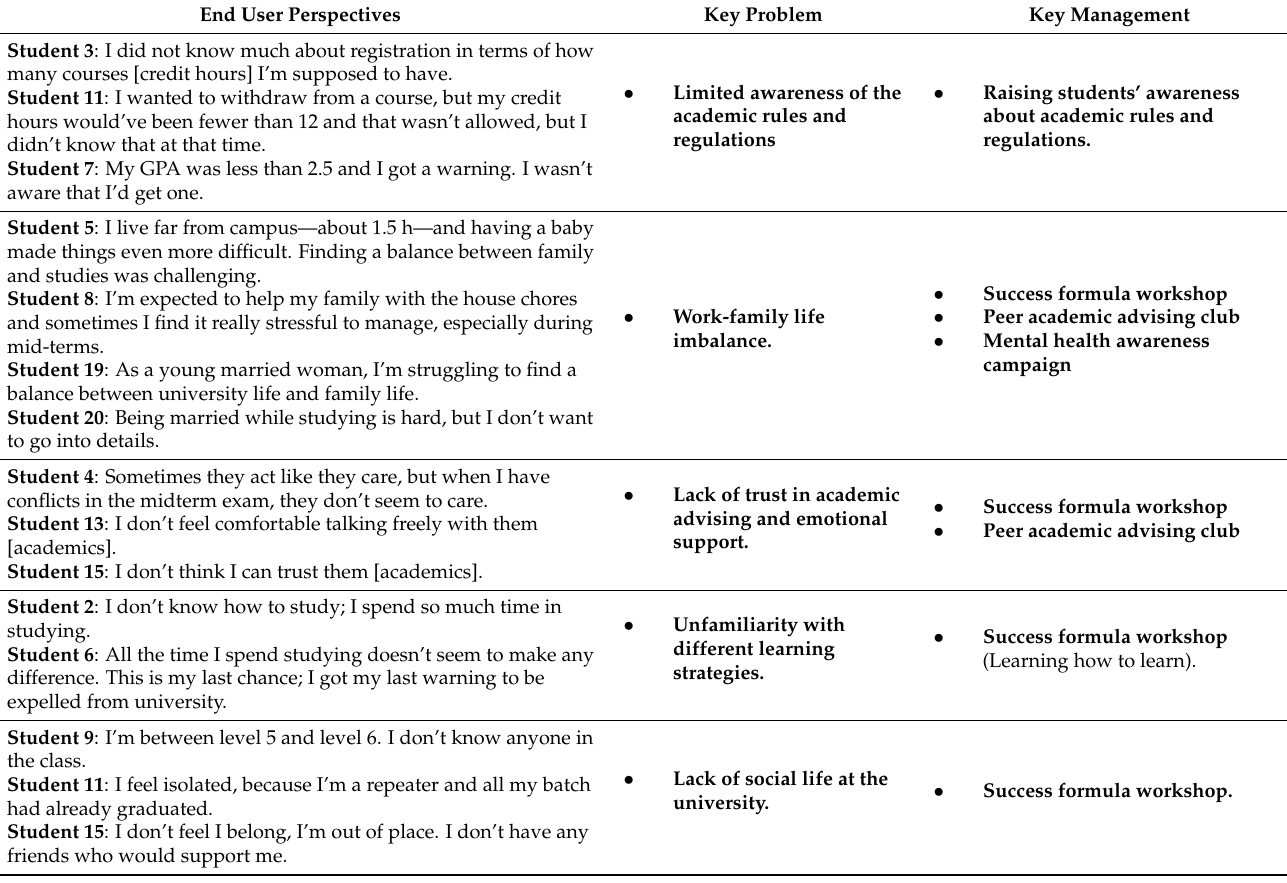
Table 2. Academic advising